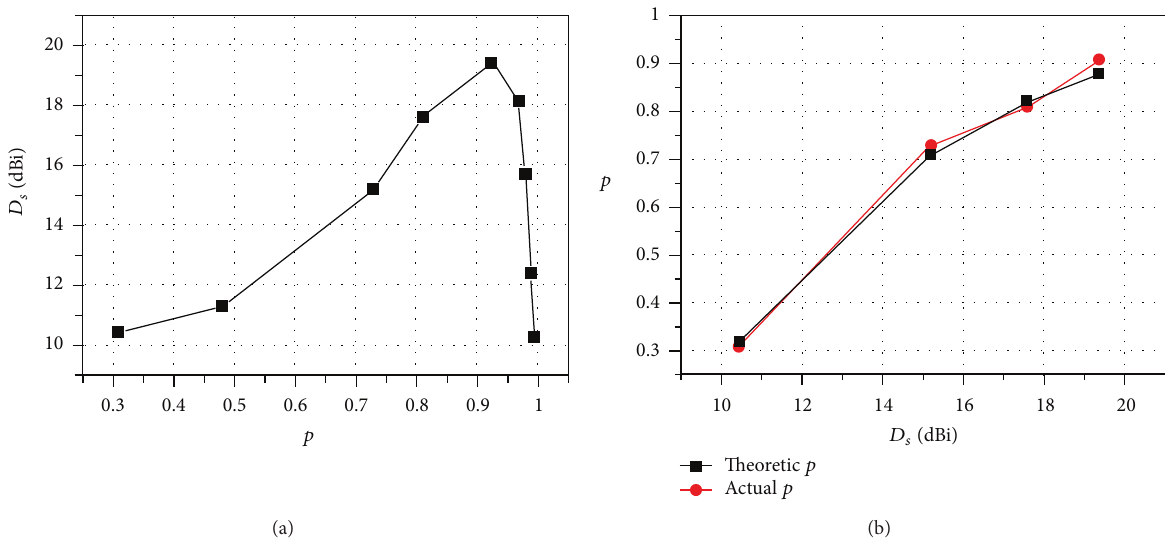
Figure 7: (a) Directivity of the patch antenna with FSS superstrates versus different 𝑝 , (b) comparison of the theoretic and the actual 𝑝 corresponding to the antenna directivity enhancement.